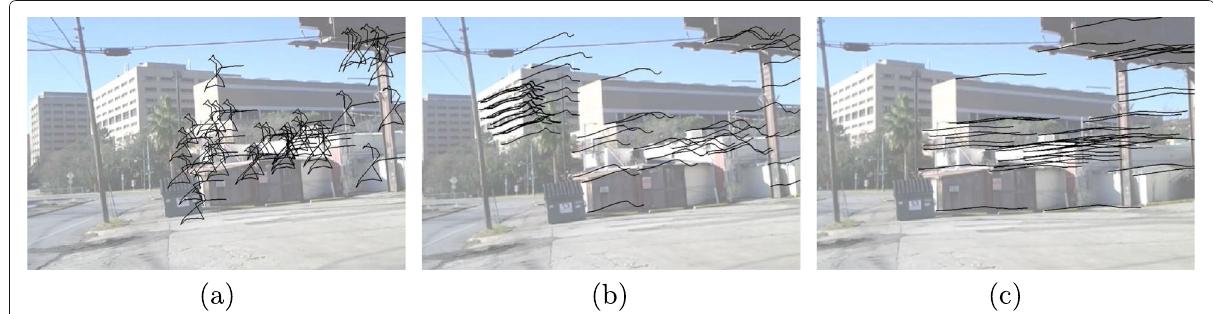
Fig. 11 Stabilization comparison for video1. Features are tracked from frame 256 to frame 275. The feature tracks are plotted as blackcurves on frame 256. a Original video. b Proposed translational smoothing. c Proposed affine smoothing